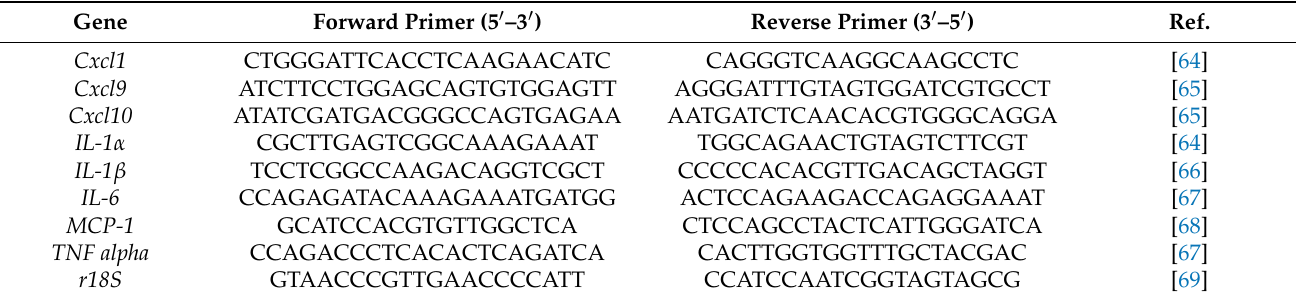
Table 1. Primer sequences used in this